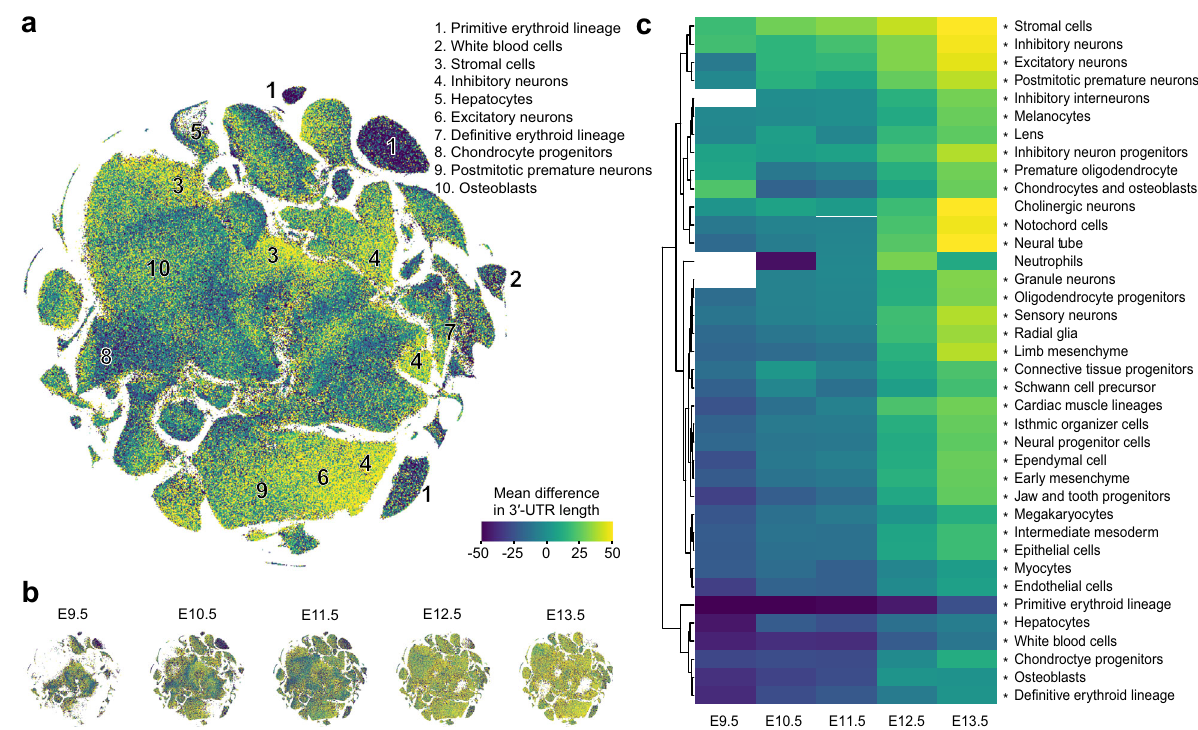
Fig. 2 Differential 3 ′ -UTR lengthening among diverse cell types and developmental stages. a t-SNE embedding of all cells from all developmental stages sampled 31 , with each cell colored according to the mean difference in 3 ′ -UTR lengths across all genes. The top-ten ranked clusters with the greatest differences are annotated according to their corresponding cell type. b Shown are the same embeddings and color scales as those in ( a ), except after partitioning the dataset into its fi ve composite developmental stages (spanning E9.5 – E13.5). c Heatmap of the mean difference in 3 ′ -UTR length after aggregating cells from each developmental stage and cell type, derived from each of 38 t-SNE clusters. Color scales are the same as those shown in ( a ). Missing values (shown in white) correspond to instances with too few (<20) cells to accurately estimate. Heatmap is clustered by Euclidean distance as a distance metric. Signi fi cant differences between the group means (i.e., for each row) were assessed by a one-way ANOVA test, with P values adjusted for multiple hypothesis testing with a Bonferroni correction (* P < 0.001). Exact P values are provided in Supplementary Table 1. See also Supplementary Fig. 4 for comparisons among t-SNE subclusters and an analysis of potential confounding